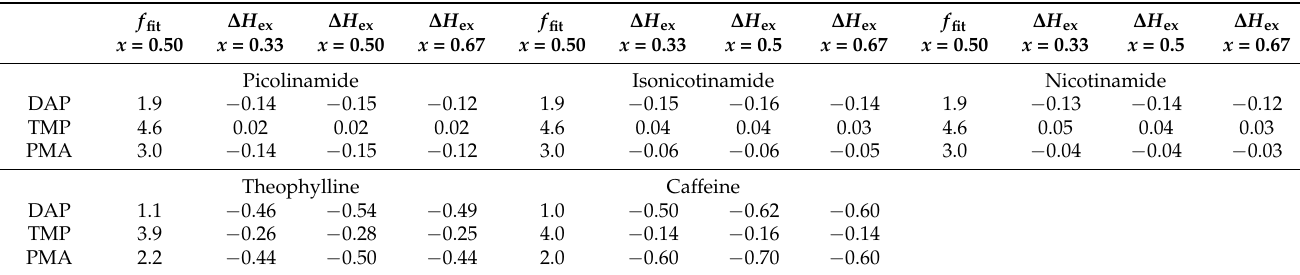
Table 1. COSMOquick parameters, ∆ H ex (kcal mol − 1 ) and f fit , obtained for co-crystal screening between the target compounds 2,4-diaminopyrimidine, trimethoprim and pyrimethamine, and the co-formers, picolinamide, isonicotinamide, nicotinamide, theophylline and caffeine; x is the target compound mole fraction. f fit x =